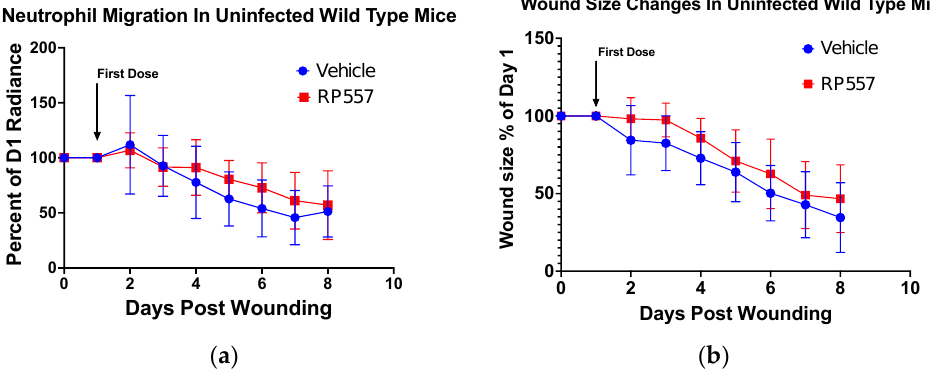
Figure 3. RP557 showed no toxicity in vivo. Nondiabetic LysM-EGFP mice that produced eGFP fluorescent neutrophils were wounded and treated with vehicle control or RP557. ( a ) Neutrophil recruitment into the uninfected wound was measured as a function of eGFP fluorescence radiance (photons/second) using an IVIS Spectrum. ( b ) Wound closure was also measured in these mice. n = 11 from three independent experiments.